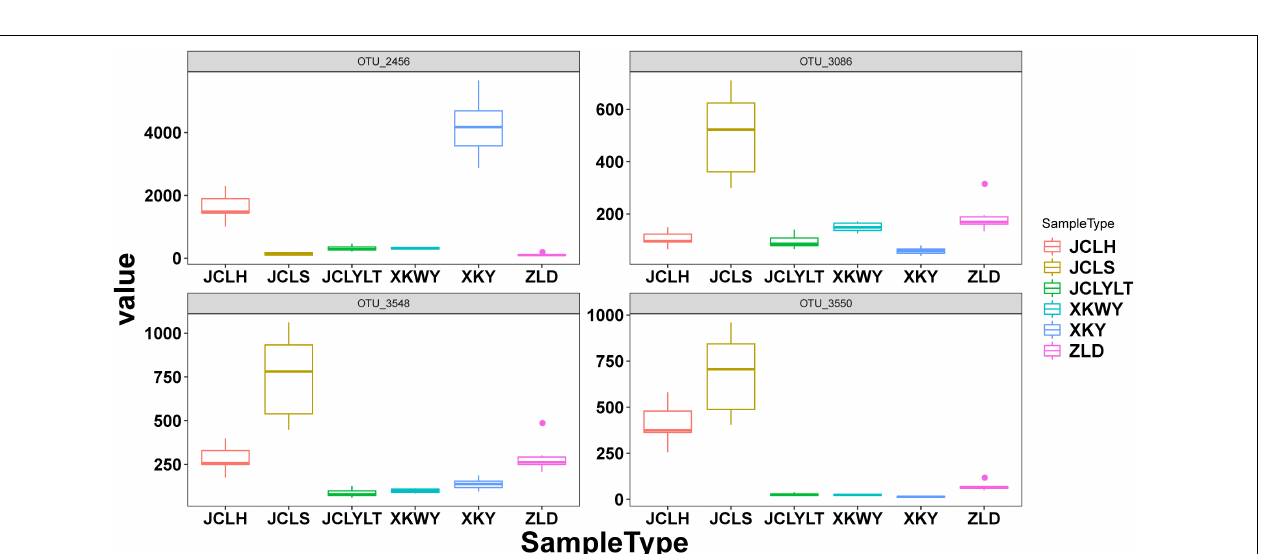
Frontiers in Microbiology |